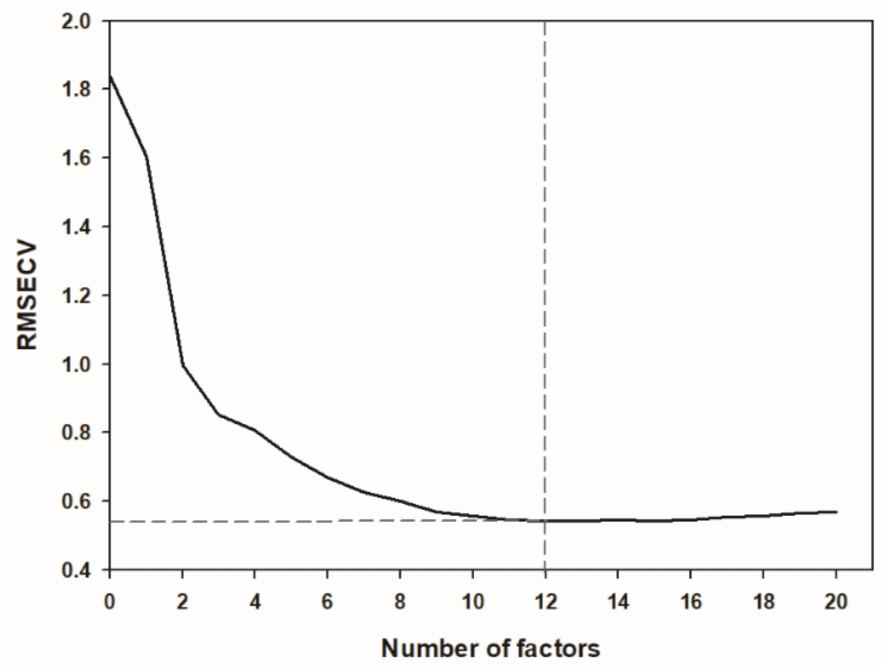
Figure 6. Number of factors and Root Mean Square Error of Cross Validation (RMSECV) obtained through the cross-validation process using a PLSR method. The number of factors considered optimum is indicated by the dashed